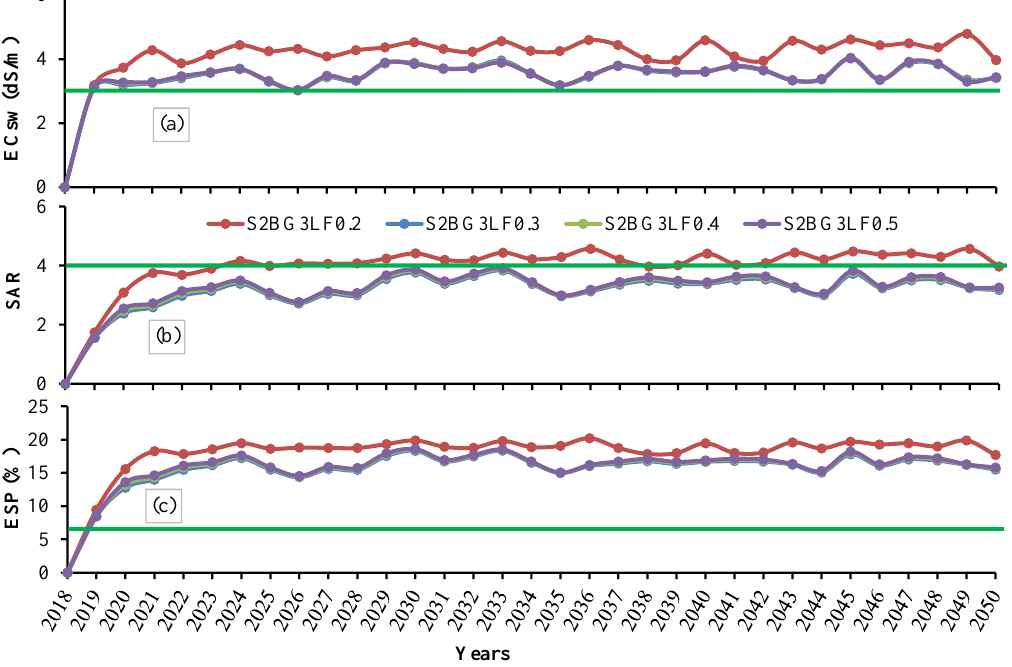
Figure 13. Impact of different leaching fractions (LF0.2, LF0.3, LF0.4, and LF0.5) and annual gypsum applications of 8.6 t/ha (G3) on ( a ) EC sw , ( b ) SAR, and ( c ) ESP in the 0–15 cm soil layer of the hard red-brown soil (S2) under a 1:1 blend of recycled (RW) and good water (GW) irrigation of almonds.